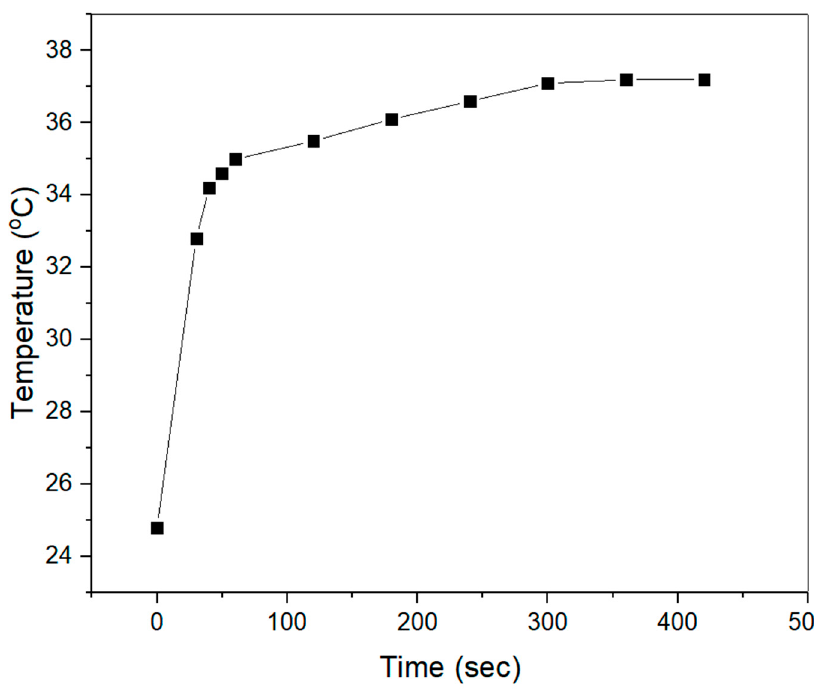
Figure 16. Graph of thermal pad temperature of on the evaluation board against time.